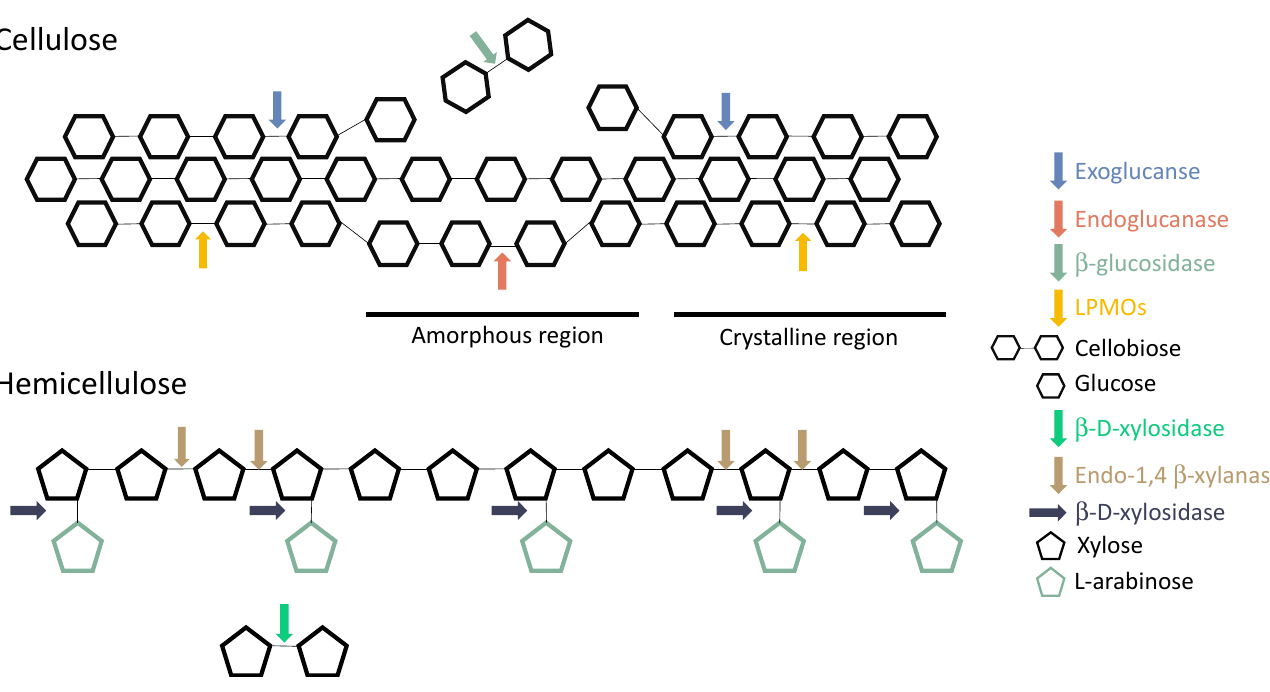
Figure 2. Schematic view of cellulose and hemicellulose hydrolysis. Depolymerization of lignocellulose is a complex process that requires the concerted action of many microbial enzymes. Cellulose chains are first degraded by the combined action of two classes of cellulases: endoglucases and exoglucanases (also known as cellobio- hydrolases) [18]. Endoglucanases act randomly, cleaving internal glycosidic bonds and releasing oligosaccharides of different lengths, whereas cellobiohydrolases act on cellulose ends, releasing cellobiose [19]. The process is completed by β -glucosidases, which further hydrolyze cellobiose units to glucose (Figure 2). Unlike cellulose, the hydrolysis of the hemicellulose component requires several different enzymes, due to its high heterogene- ity [20]. Because xylan is, on average, the most abundant component of hemicellulose